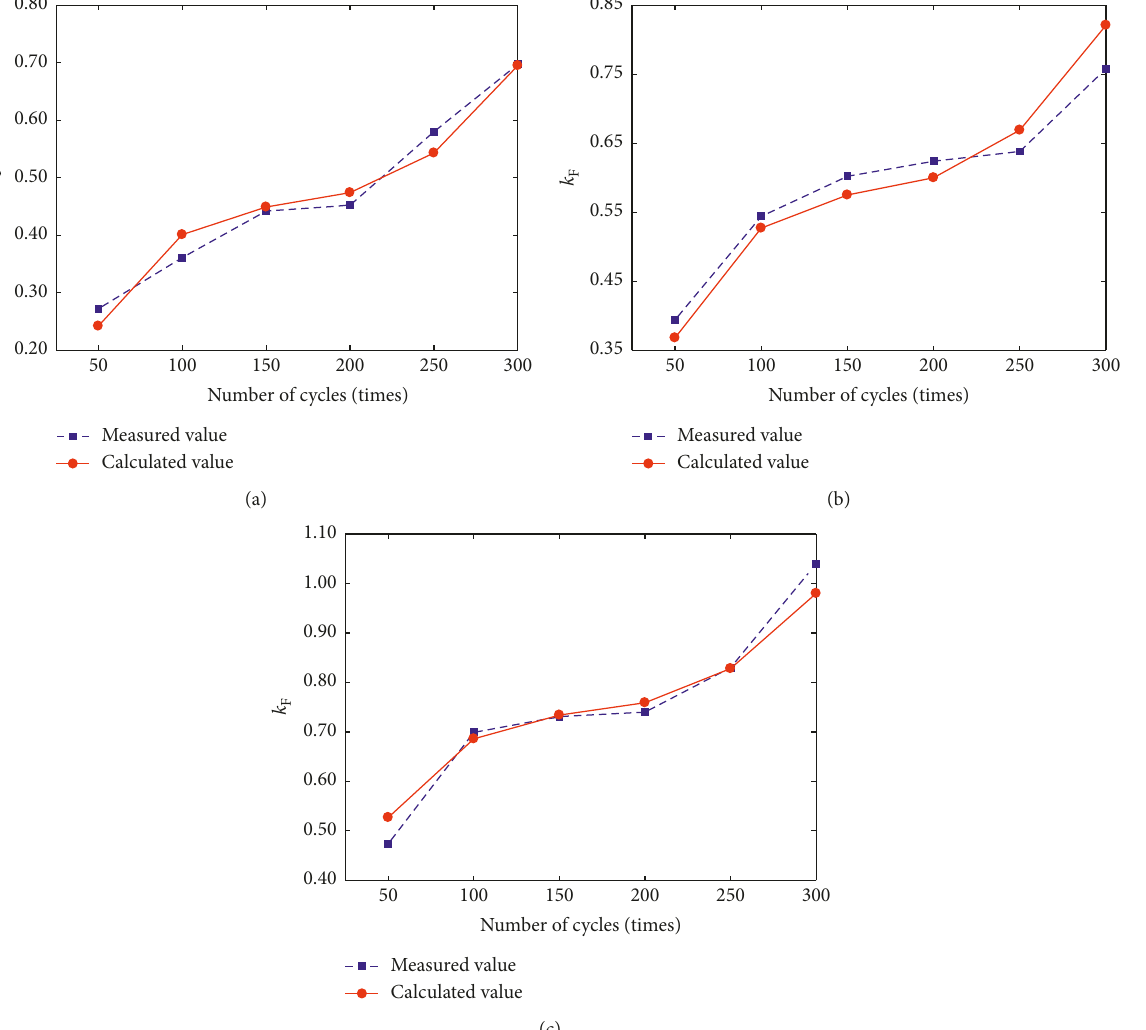
Figure 8: Comparison of measured value and calculated value of the composite damage coefficient k (c)